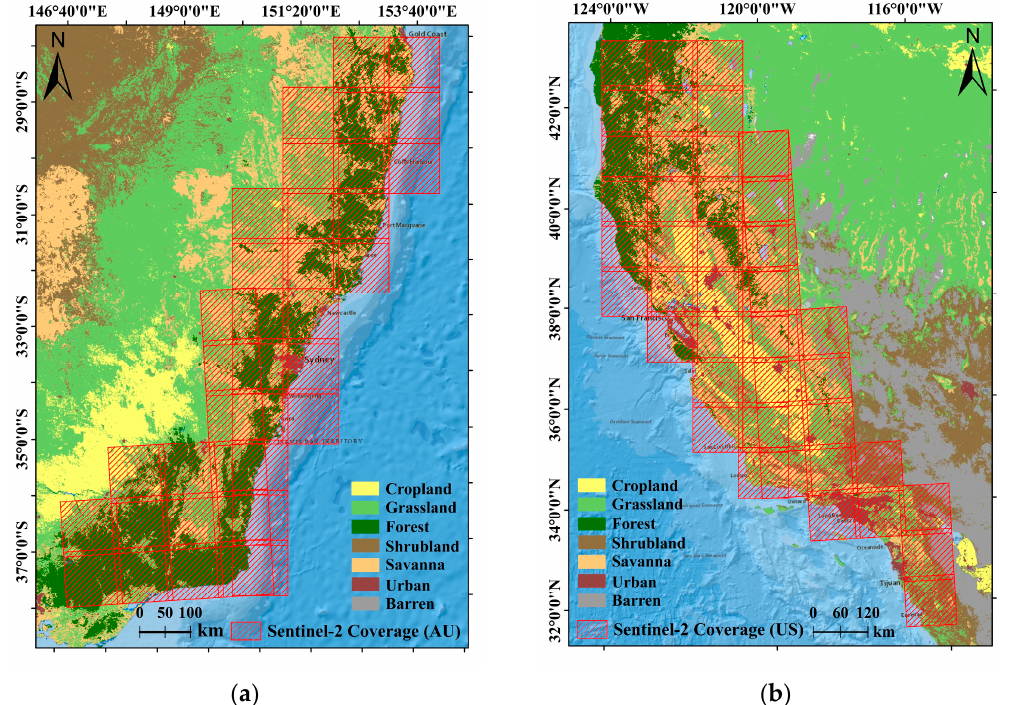
Figure 1. Sentinel-2 image coverage used for constructing dataset: ( a ) Australia; ( b ) the United States. Base map: land cover map derived from the 2019 Version 6 MODIS Land Cover Type (MCD12Q1) product [31].